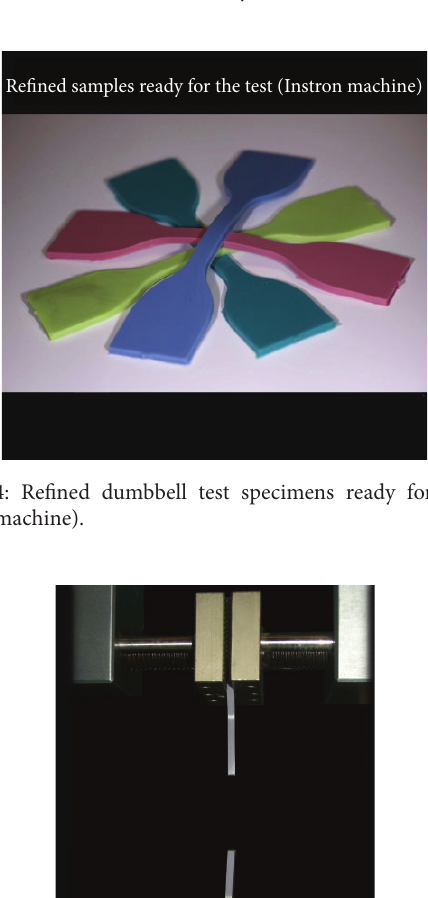
Table 3: Mean values (and standard deviations, SD) recorded for tensile strength at break (TSb), yield strength (YS), ultimate strain at break (USb), and strain at yield point (Sy) in the different experimental groups.